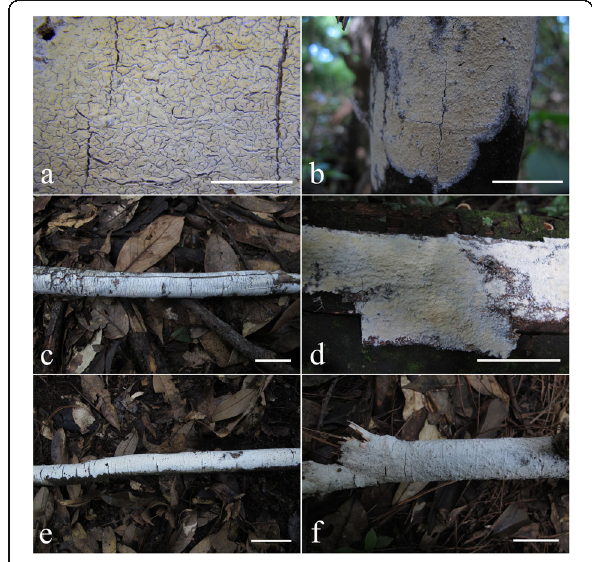
Fig. 12 Basidiomes of Skvortzoviella lenis . a , b LWZ 20180921-17 (holotype). c LWZ 20180921-32 (paratype). d LWZ 20180921-25 (paratype). e LWZ 20180922-39 (paratype). f LWZ 20180922-61 (paratype). Scale bars: a = 5 mm; b = 5 cm; c – f = 3 cm